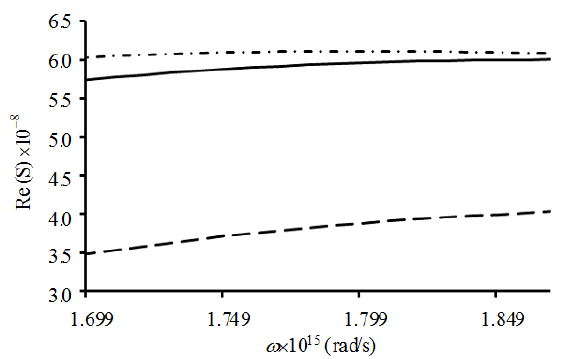
Fig. 5 Real part of the sensitivity for TE 1 versus frequency at different values of d . Dash line is when d = 75 nm, solid line is when d = 65 nm, and dash-dotted line is when d = 55